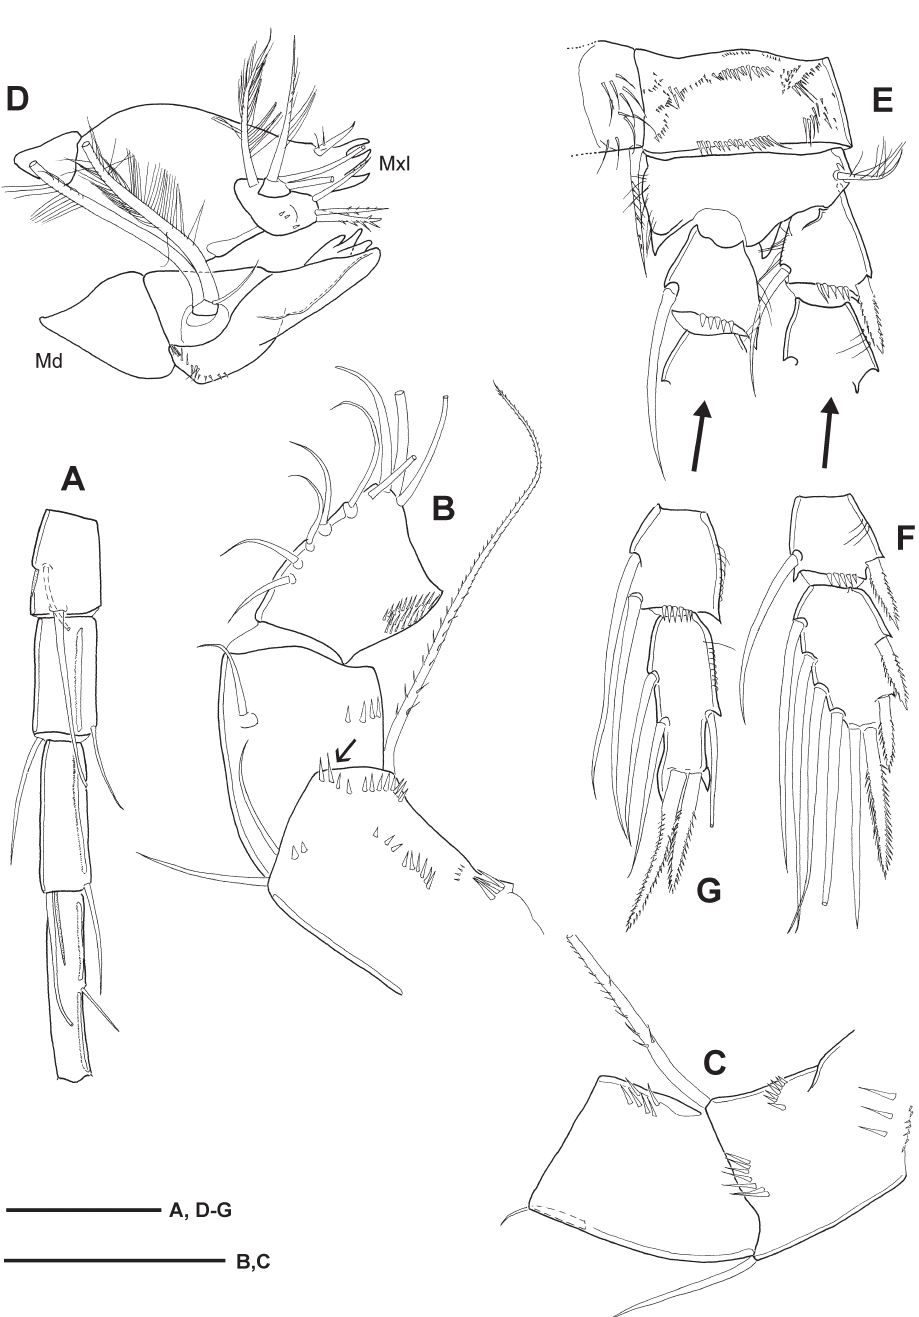
Fig. 7. Eucyclops agiloides (G.O. Sars, 1909) (Lake Victoria, paratype, ♀; NHM). A . Antennulary segment 9−12, ventral surface (terminal setae of segment 12 are not figured). B . Antennal coxobasis and first and second endopodal segments, caudal view – note the group of spinules next to distal margin (arrow). C . Antennal coxobasis and first endopodal segment, frontal view. D . Mandible (Md) and maxillule (Mxl). E . Leg 4, protopodite and first exopodal and endopodal segments, caudal view. F . Leg 4, second and third exopodal segments, caudal view. G . Leg 4, second and third endopodal segments, caudal view. Scale bars: A−G = 50